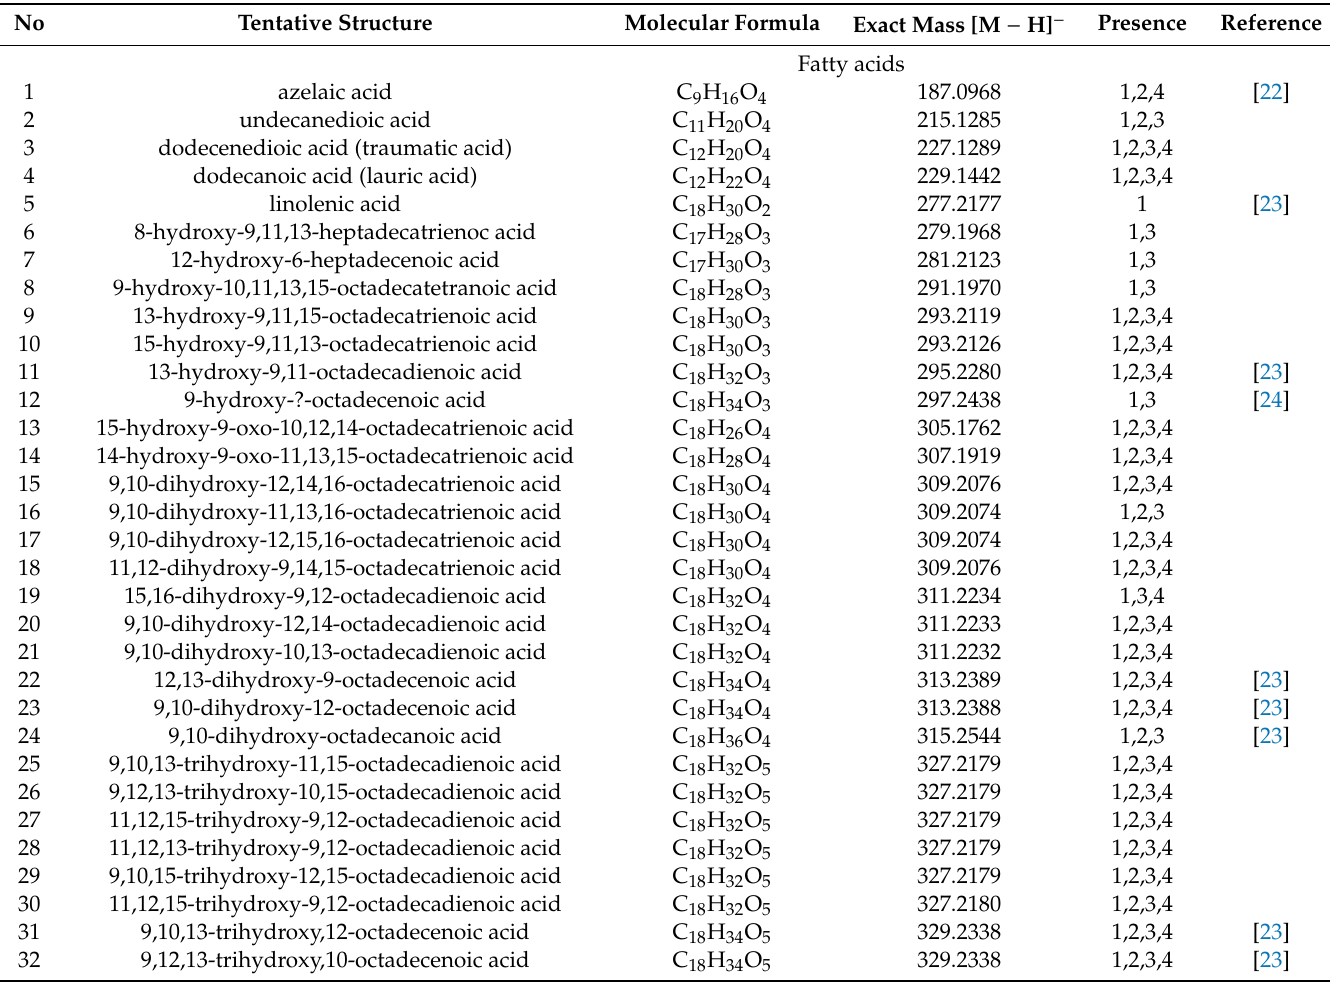
Table 1. Peak assessment of metabolites in Achyranthes aspera